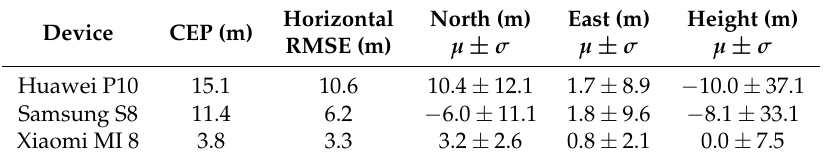
Table 1. Statistics of the positioning solutions obtained from smartphones in a real environment. Horizontal North Device CEP (m) RMSE (m)